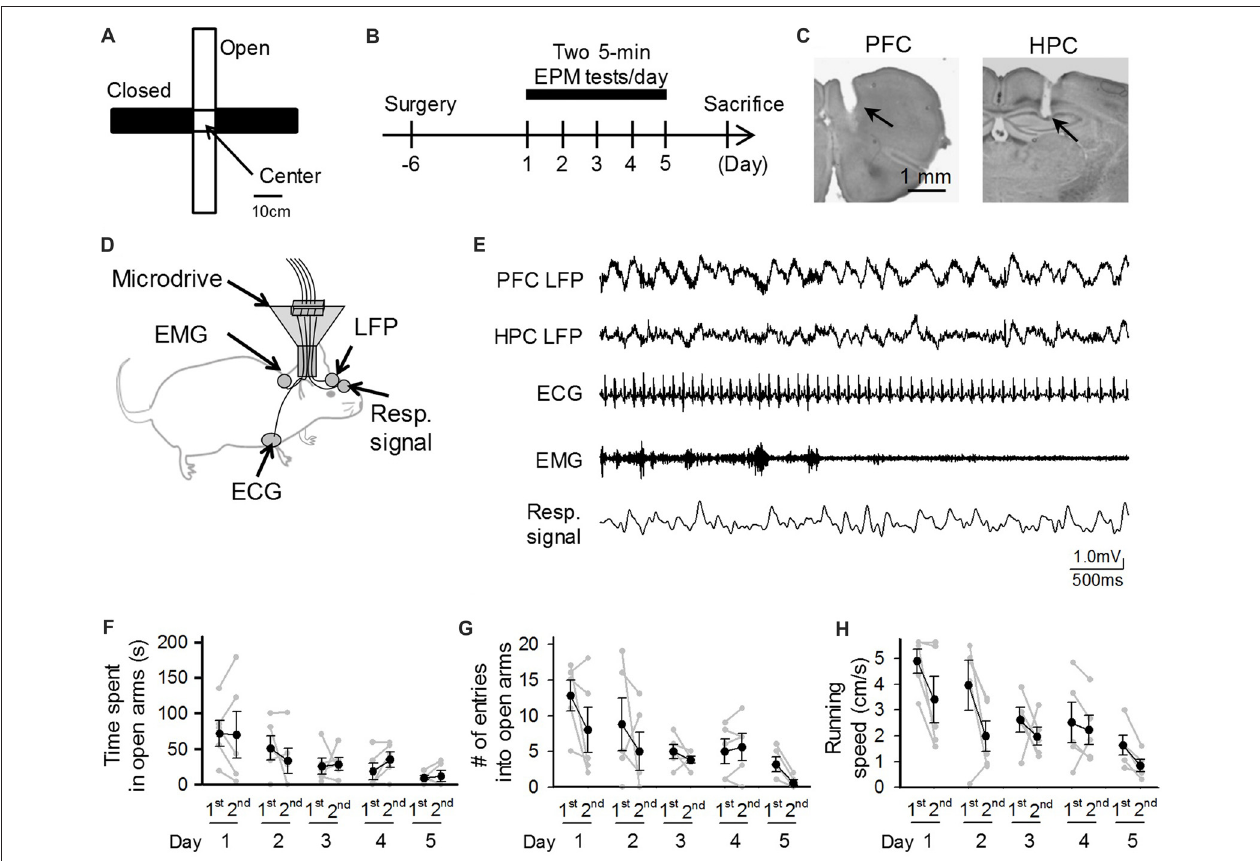
FIGURE 1 | Behavioral performances of mice repeatedly exposed to elevated plus maze (EPM) tests. (A) An overview of the maze. (B) A mouse was subjected to EPM tests for five consecutive days. One recording day was composed of two 5-min sessions (1st and 2nd sessions) with an intersession interval of 10 min. (C) Histological confirmation of a recording site in the prefrontal cortex (PFC) and dorsal hippocampal CA1 (HPC) areas in a cresyl-stained section. The arrowheads indicate the electrode tracks. (D) Schematic illustration of the recording configuration from a freely moving mouse. (E) Representative electrophysiological recordings of local field potential (LFP) signals from the PFC and HPC, an electrocardiogram (ECG) signal, an electromyogram (EMG) signal from the dorsal neck muscle, and a Resp signal from the olfactory bulb. (F–H) Average percentage of time spent in open arms, number of entries into open arms, and running speed in the maze. Each gray dot represents one mouse. The statistical results in these figures are described in the main